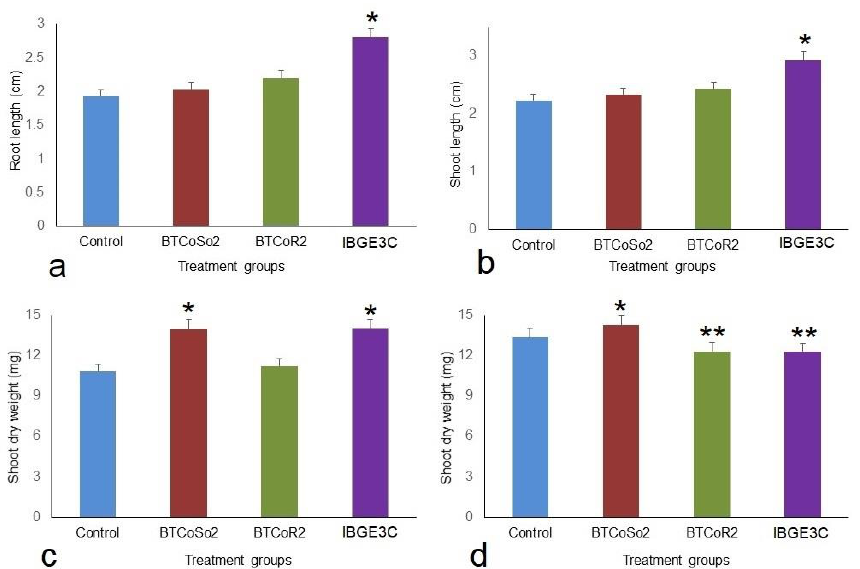
Figure 7. Effects of bacterial isolates on ( a ) root length; ( b ) shoot length; ( c ) root dry weight, and ( d ) shoot dry weight in BINAdhan-10 rice seedlings under 1% salinity. IBGE3C was identified as Brevibacterium sediminis . From left to right, treatments are indicated under columns. Results are expressed in relative length and dry weight compared to control where values are means and bars indicate standard errors ( n = 3 ). * p < 0.05 and ** p < 0.005 as compared to control.